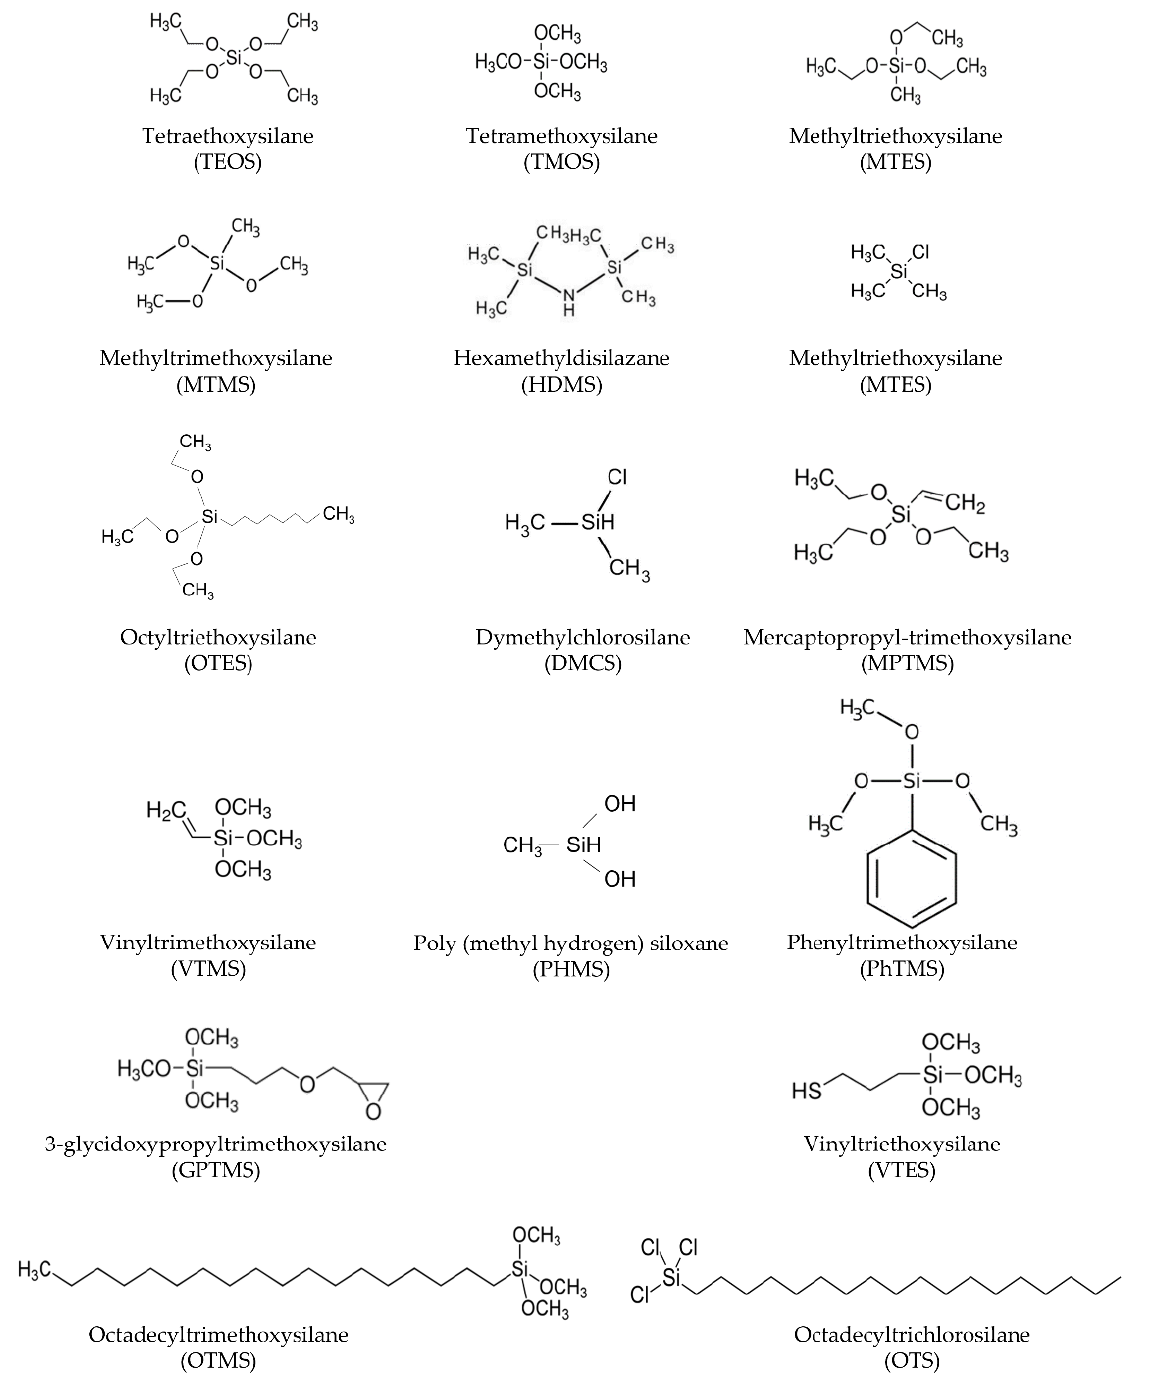
Figure 1. Nomenclature for all silanes reported in the review, including the corresponding abbreviations in brackets.